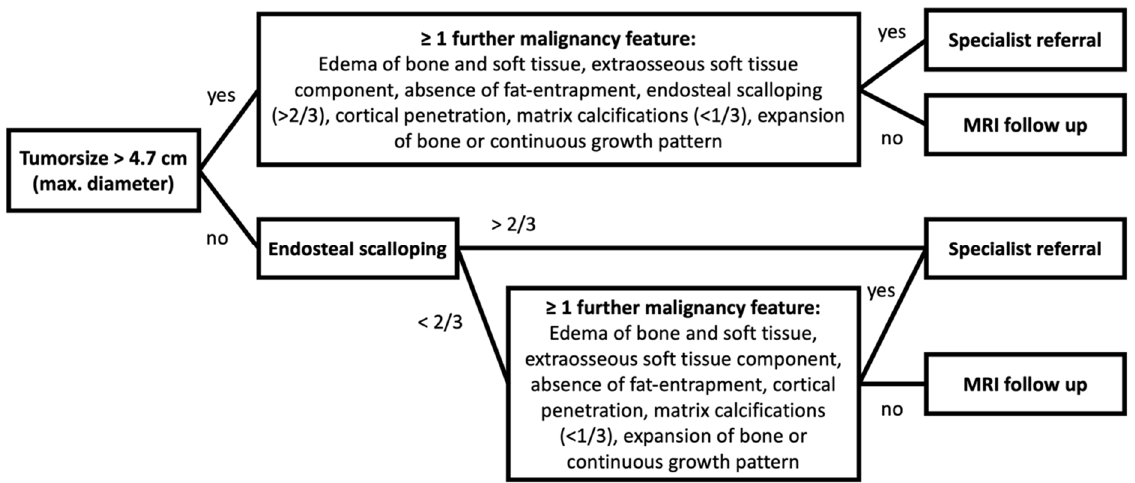
Figure 4. Flow chart for diagnostic procedure based on imaging findings in MRI and CT.